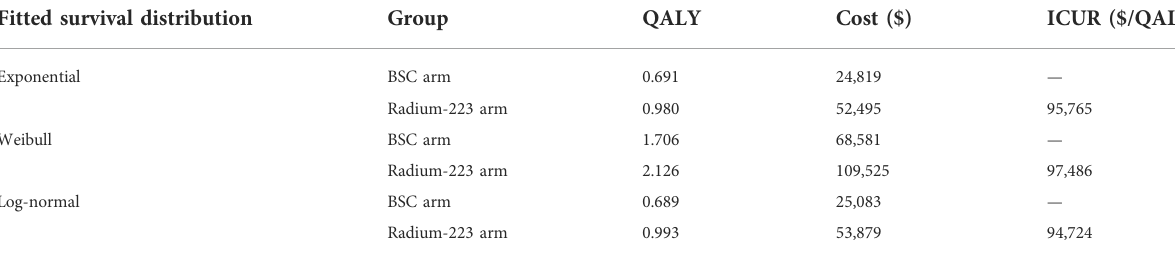
TABLE 4 Scenario analyses using different fi tted survival curves. Fitted survival